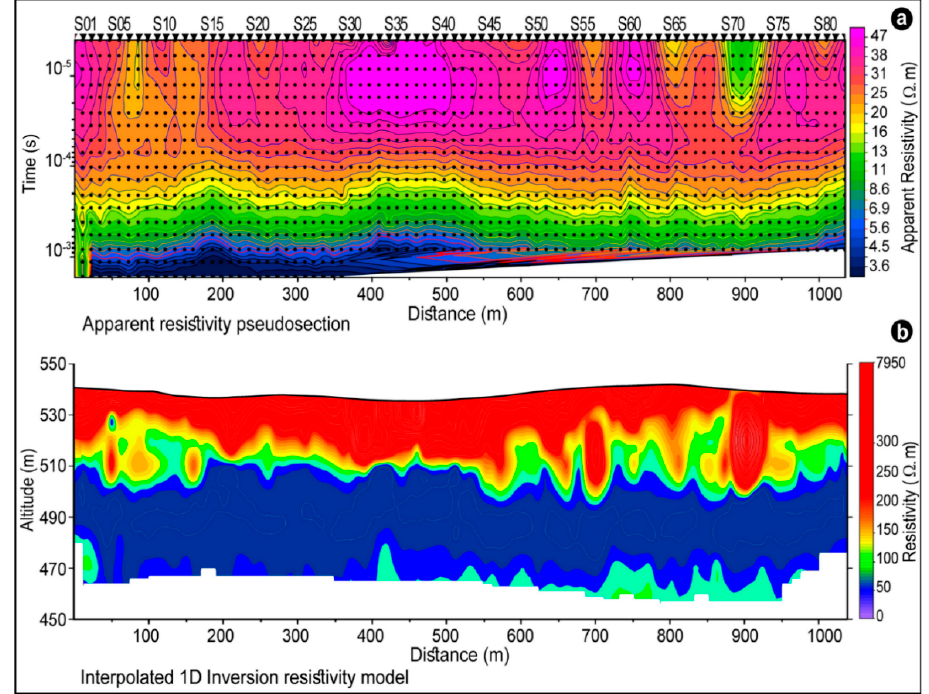
Figure 6. ( a ) Time-domain electromagnetic (TDEM) pseudo-section of experimental resistivity data from TDEM sounding survey, ( b ) interpolated 1D inversion resistivity model.